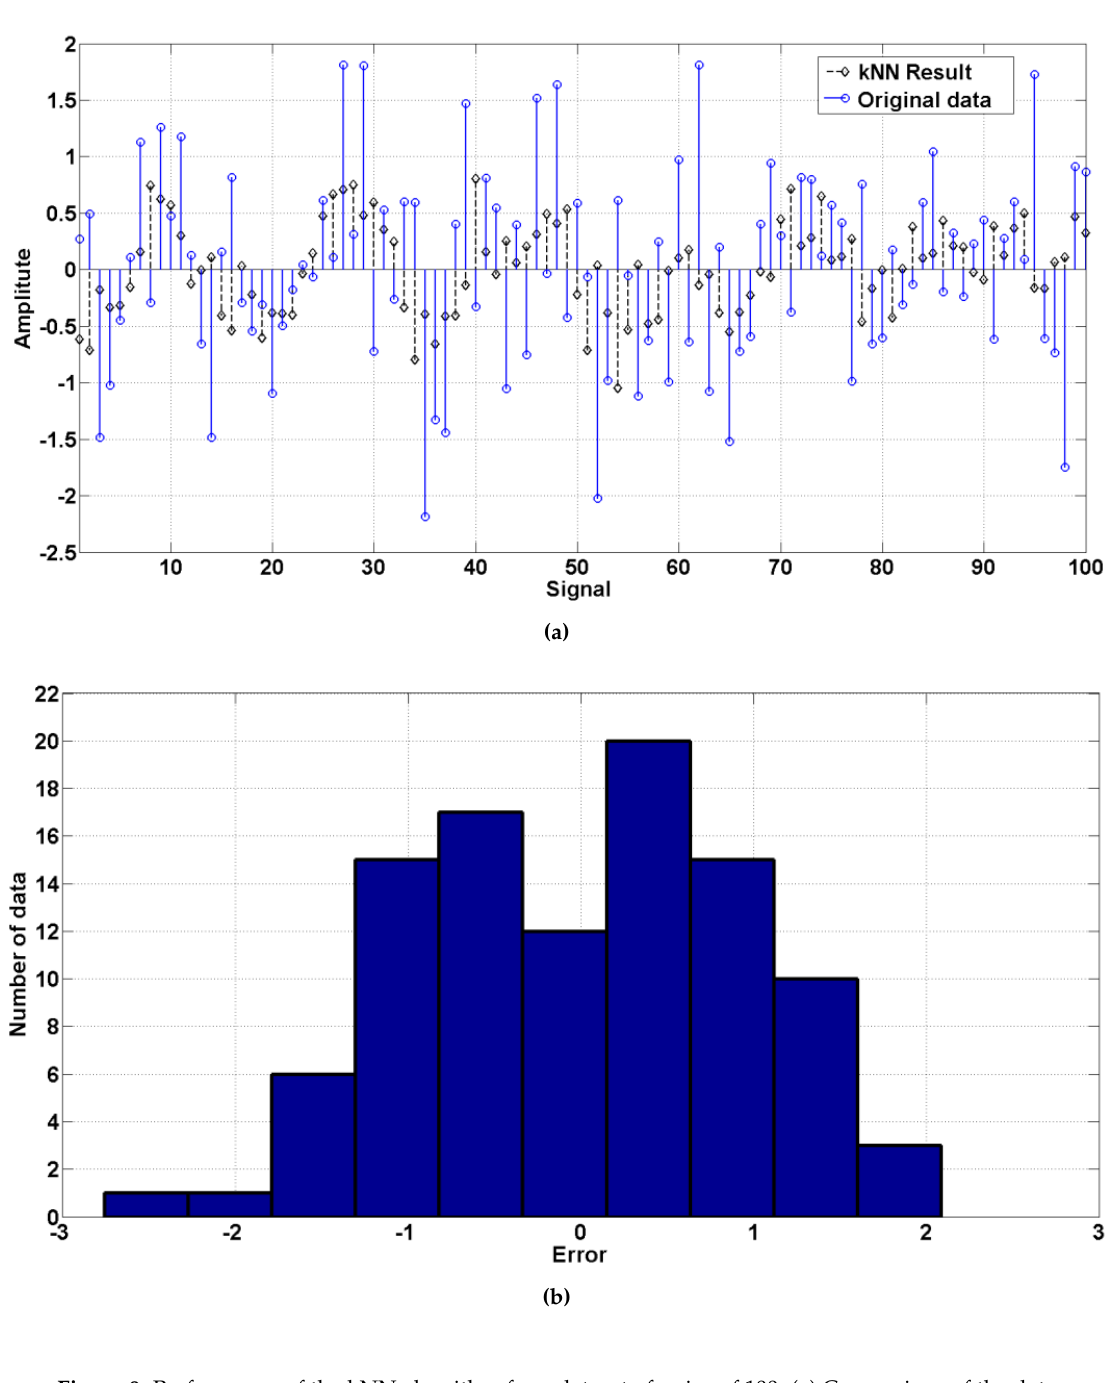
Figure 9. Performance of the kNN algorithm for a dataset of a size of 100. ( a ) Comparison of the data values and their prediction by the kNN algorithm; ( b ) histogram of the error